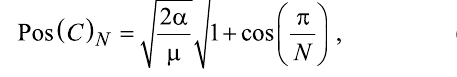
curve from Equation 1 is presented in red, and the experimental curve is in green. In Figure 5b, there is a low frequency part of the Raman spectrum for sample GMSE4, given with its C -peak.